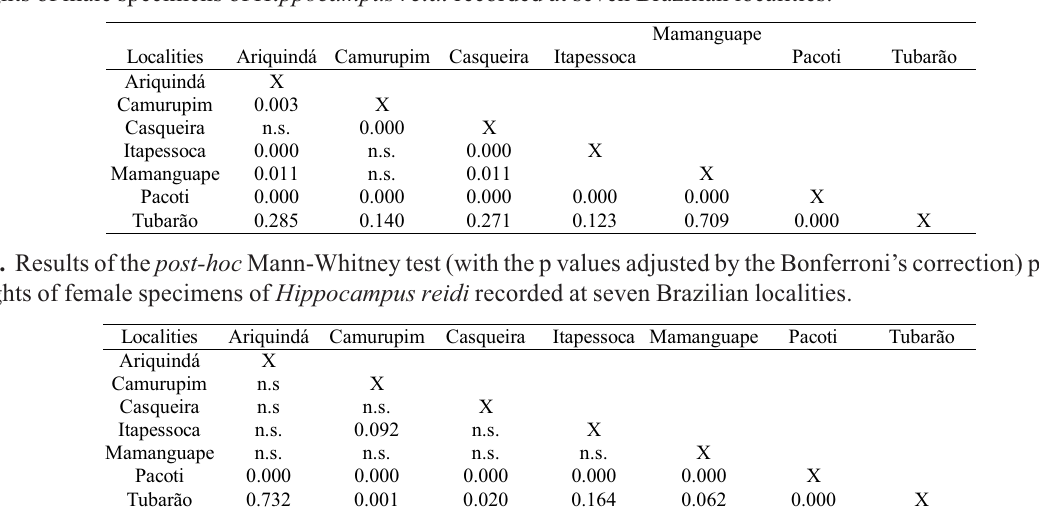
Table 3. Results of the post-hoc Mann-Whitney test (with the p values adjusted by the Bonferroni’s correction) performed on the heights of male specimens of Hippocampus reidi recorded at seven Brazilian localities.